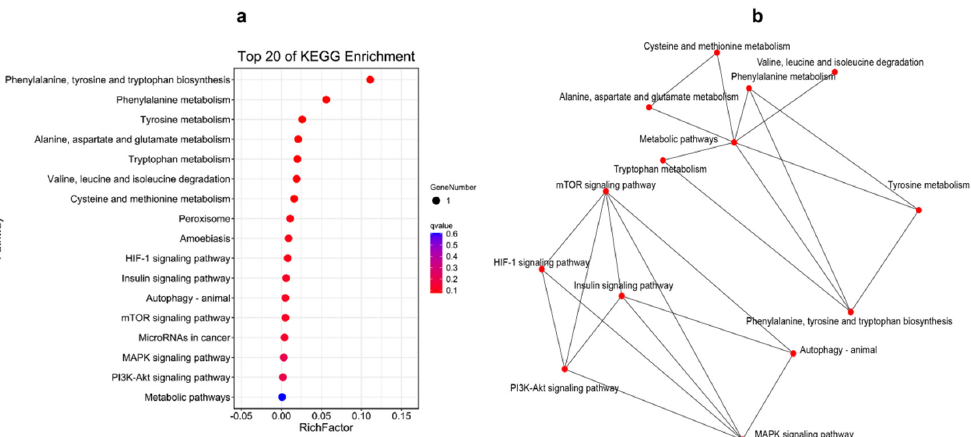
Figure 8. The Top 20 KEGG Pathways Enriched by the Differentially Expressed Genes of the Shared Genes Between the Liver and Spleen at 12 h Postinjection, and the Network Graph among these Pathways: ( a ) the Pathway Enrichment of the Shared Differentially Expressed Genes; ( b ) the Network Graph among these Pathways.